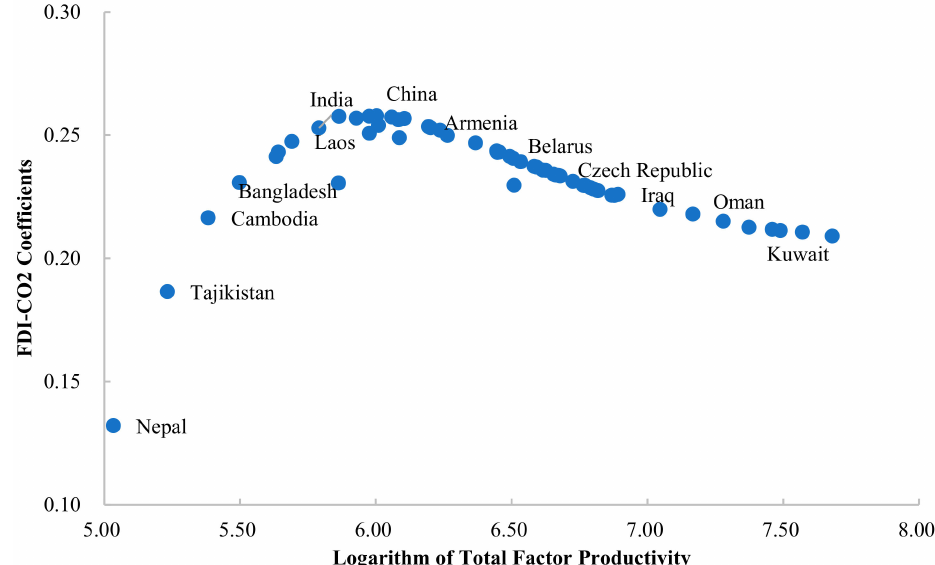
Figure 5. FDI-CO 2 coefficients of Belt and Road countries (total factor productivity